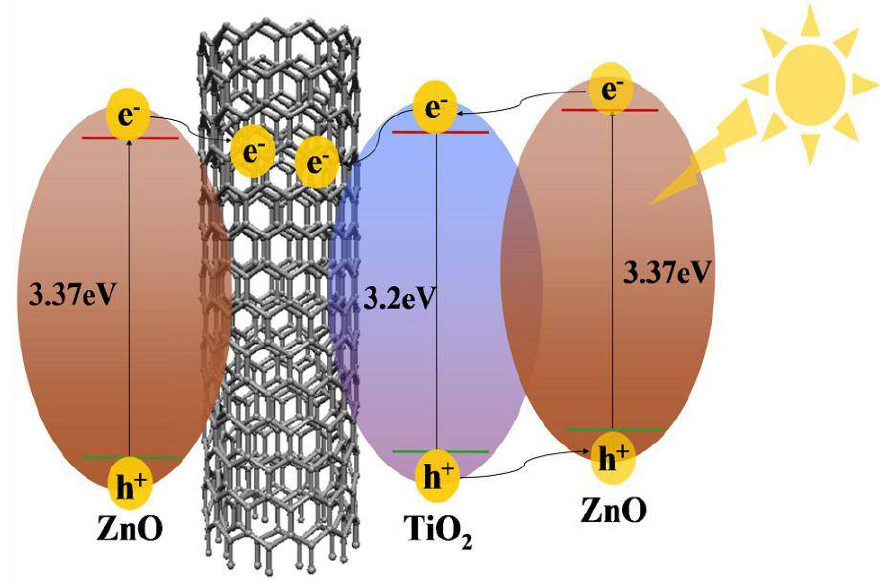
Figure 4. Schematic electron-hole separation process of CNT/TiO 2 /ZnO composites.